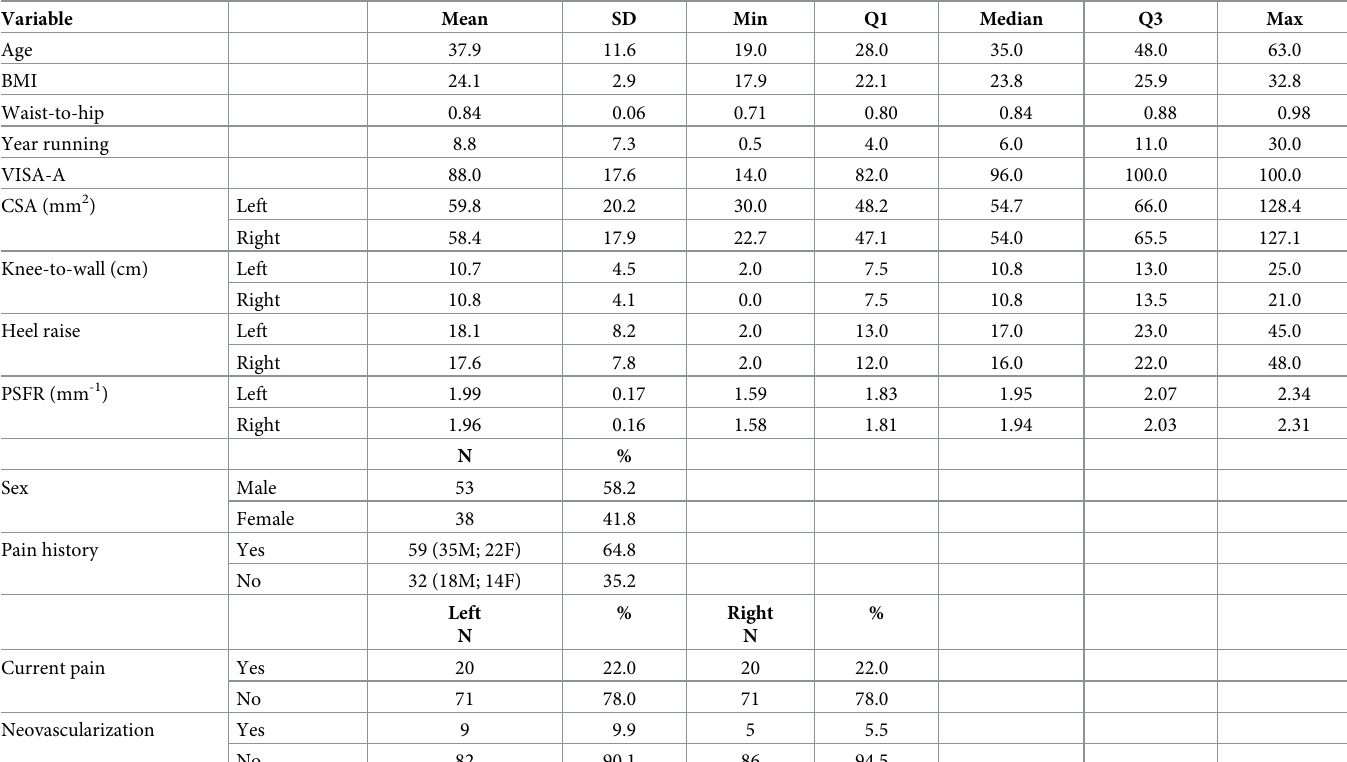
Table 1. Descriptive statistics of peak spatial frequency radius and related